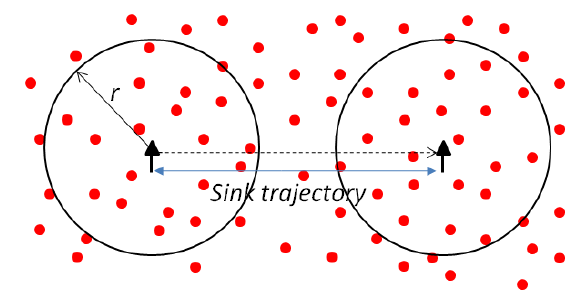
Figure 5. Computing the distribution of sensor-MS meeting